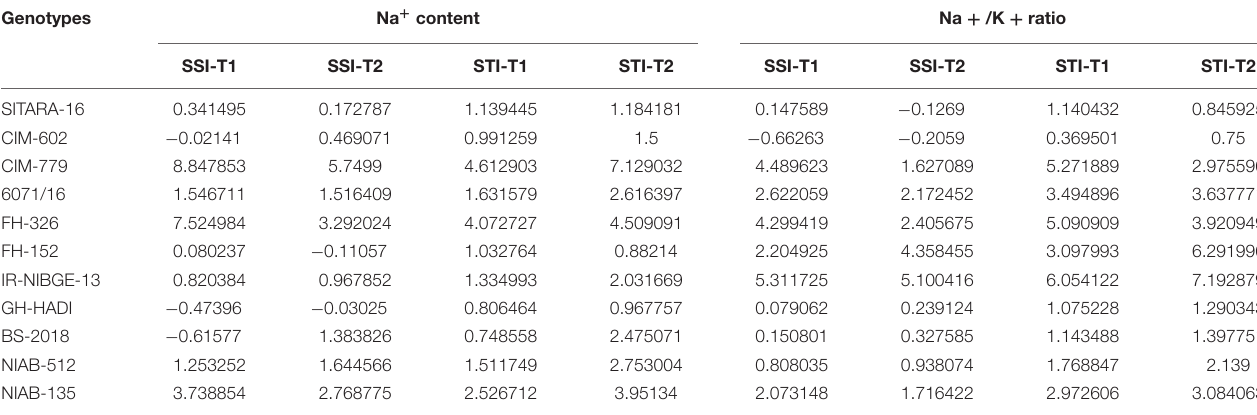
TABLE 10 | Stress susceptibility and tolerance Indices of Na + and Na + /K + ratio. Genotypes